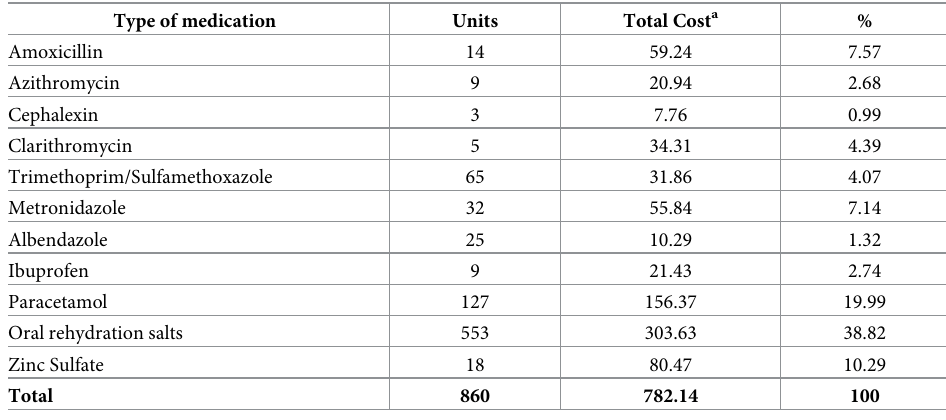
Table 6. Cost by type of